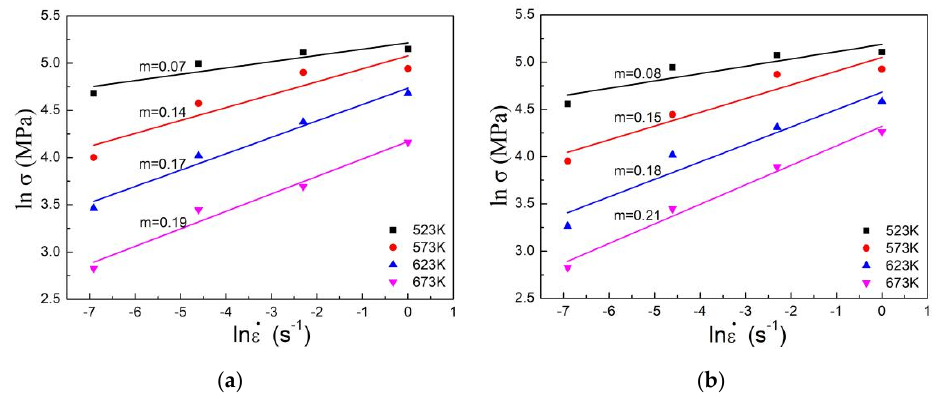
Figure 12. Strain rate sensitivity of ( a ) MZC and ( b ) MZCM.